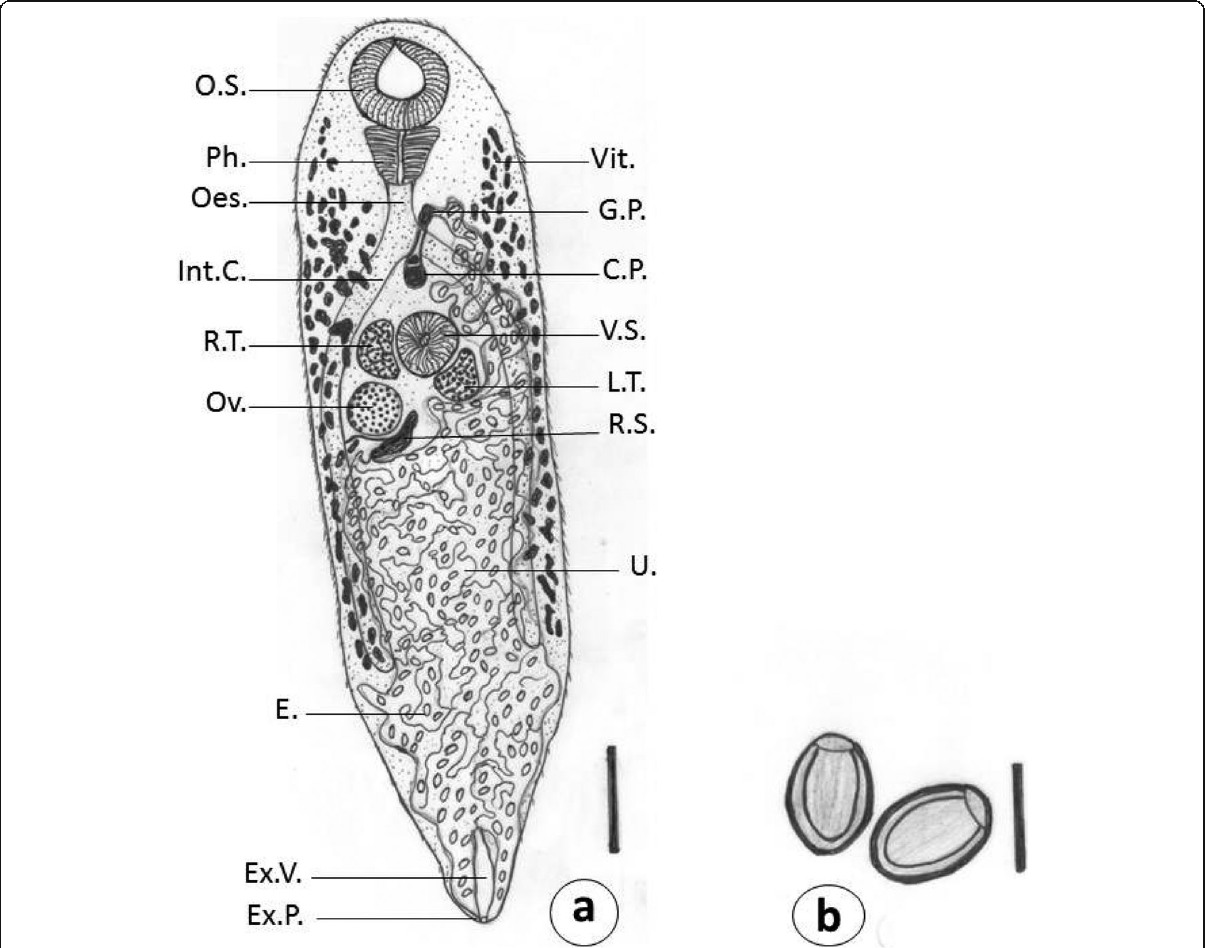
Fig. 2 Line diagram of Mesocoelium sociale . a Shows ventral view of whole worm. Abbreviations: C.P., cirrus pouch; E., egg; Ex.P., excretory pore; Ex.V., excretory vesicle; G.P., genital pore; Int.C., intestinal caecum; L.T., left testis; Oes., esophagus; O.S., oral sucker; Ov., ovary; Ph., pharynx; R.S., receptaculum seminis; R.T., right testis; U., uterus; Vit., vitellaria; V.S., ventral sucker. Scale bar = 300 μ m. b Shows the eggs. Scale bar = 30 μ